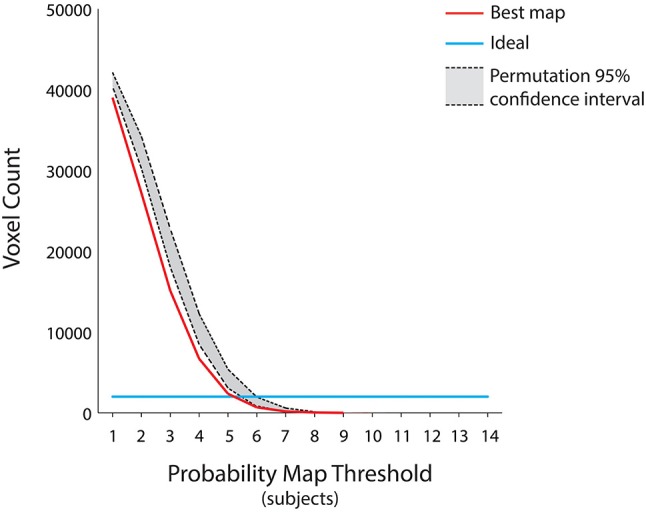
Assessment for the group level map. Since the group level map of Figure 3 was the result of the aggregation of the individual subject decoding maps at different time points, we further tested its sparseness using a permutation test by randomly combining the decoding maps at different time points across subjects and subsequently measuring the total number of voxels at each probability threshold (p < 0.05). The ideal group map (e.g., no variability across subjects) is represented by the light blue line, the group level map is represented by the red curve, whereas the 95% confidence interval of the null distribution is outlined in gray. The group level map has a number of voxels lower than the null distribution, irrespective of the chosen probability threshold. Moreover, all the group maps obtained by aggregating the subjects' decoding maps at each of the seven fixed time points fell within the null distribution area (p < 0.05).